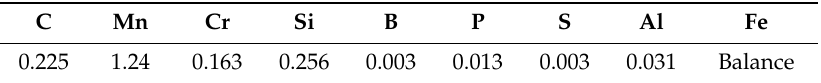
Table 1. Chemical composition of ultrahigh-strength steel 22MnB5 (wt%).